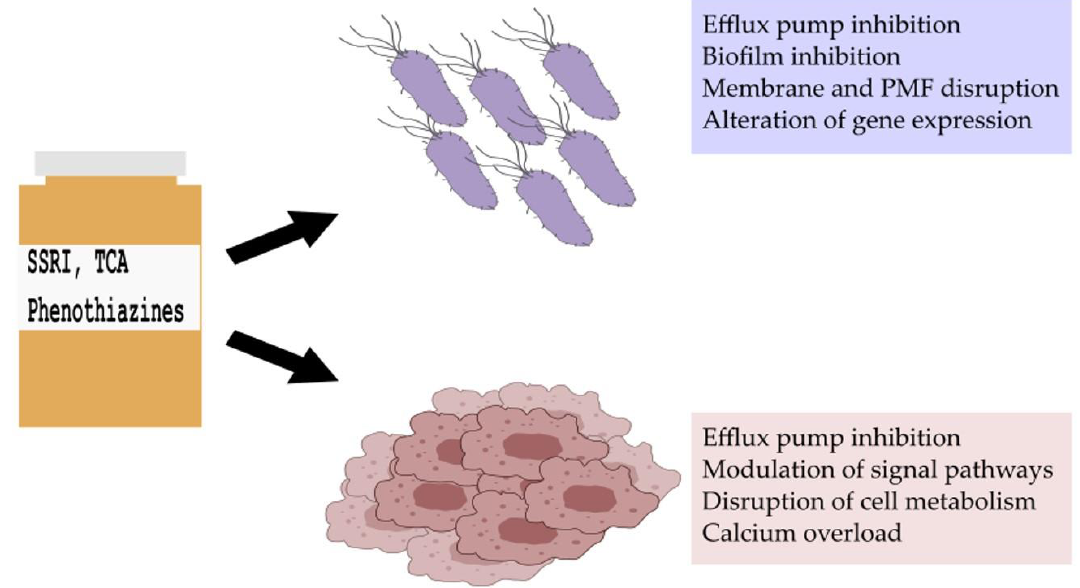
Figure 1. Antibacterial, anticancer, and efflux pump-modulating activity of selective serotonin reuptake inhibitors (SSRIs), tricyclic antidepressants (TCAs), and phenothiazine-type antipsychotics. PMF: proton motive force.